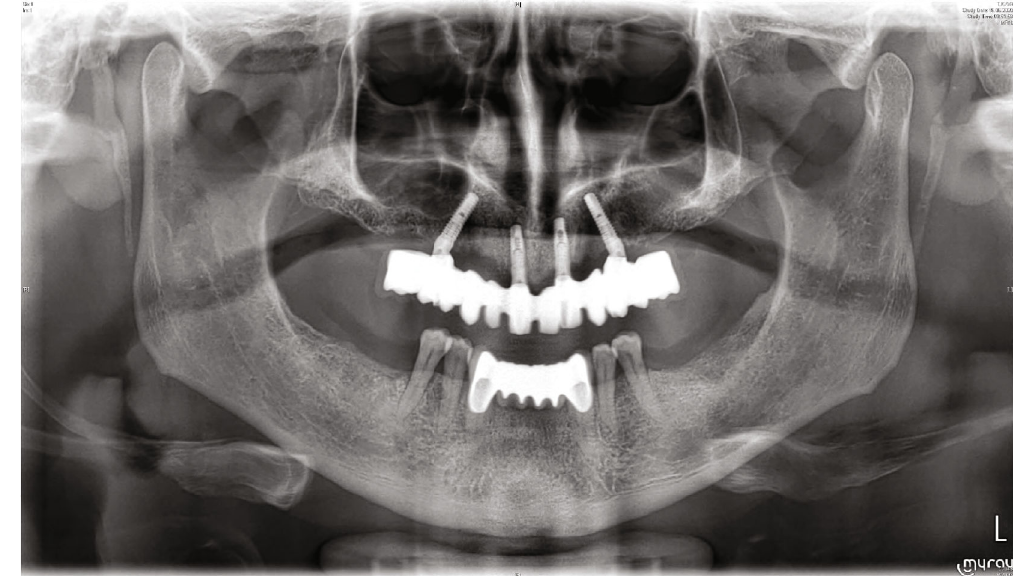
Figure 13: Orthopantomogram to control the de fi nitive